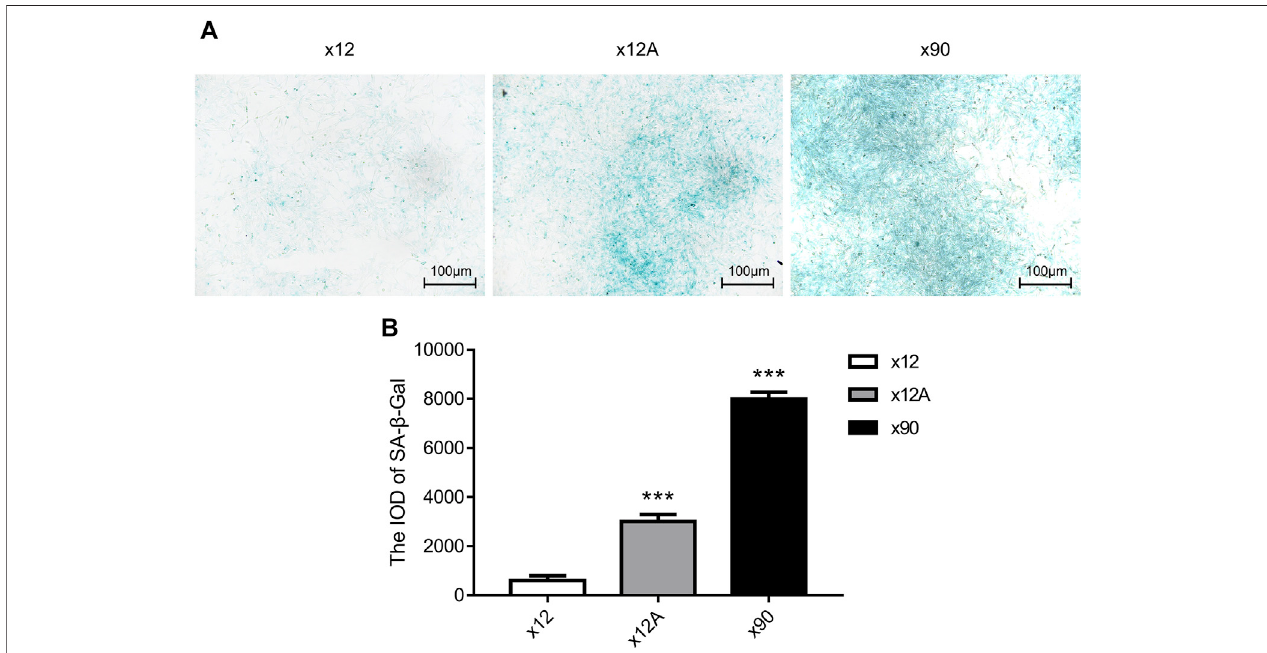
FIGURE 1 | SA- β -gal staining of primary cultured astrocytes treated by A β and cultured for 90 days. (A) Representative images of SA- β -gal staining of primary cultured astrocytes treated with A β and cultured for 90 days. Green-stained astrocytes showed higher β -galactosidase activity. (B) Quantitative analysis of SA- β -gal- positive astrocytes. Scale bar = 100 μ m. Data are expressed as the mean ± SEM. n = 5. ** p < 0.01; *** p < 0.001 vs x12